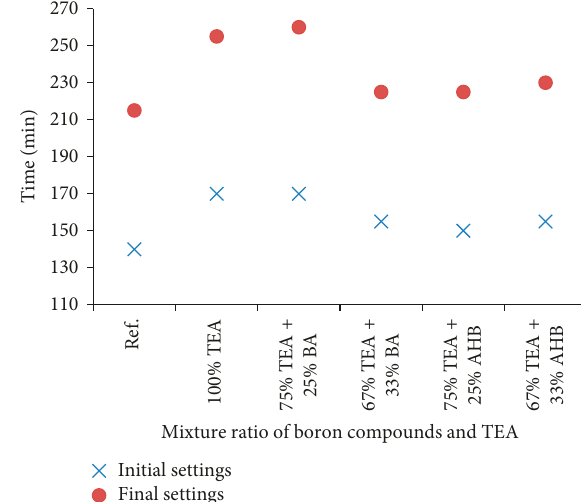
Figure 1: The initial and final setting points of the reference cement and cement mixtures milled with TEA and different ratios of BA and AHB mixtures as grinding